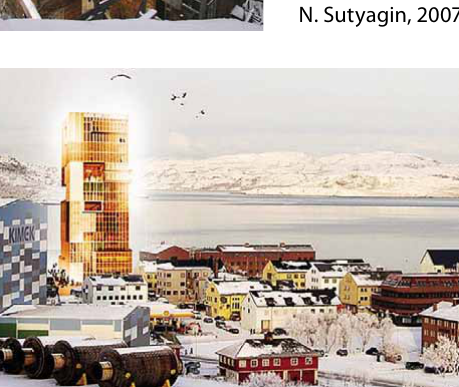
Fig. 43. House in Arkhangelsk, Russia, aut.